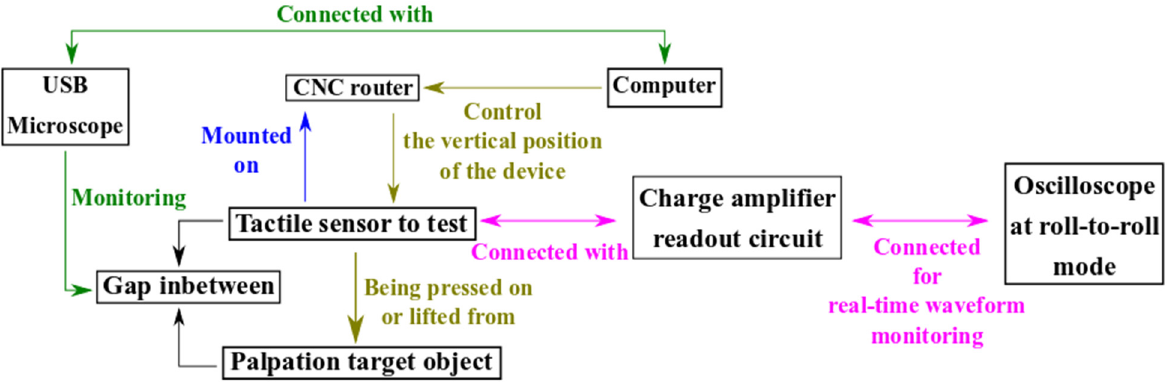
Figure 4. Fabricated device and parts. ( a ) An assembled tactile sensor and separate individual com ‐ ponents; ( b ) Screen printing process to make the electrode layers on the bottom and top surface of the PVDF ‐ TrFE film.